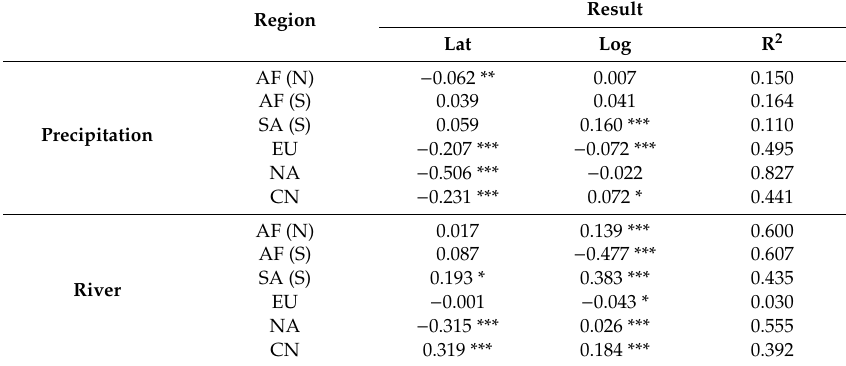
Table 3. Result of the regression analysis. Values in ‘Lat’ and ‘Log’ columns represent the fitted coe ffi cient of latitude and longitude. The symbols *, ** and *** indicate statistical significance at the significance level of 0.05, 0.01, 0.001, respectively. Values in ‘R 2 ’ columns represents the r 2 values for the regression.